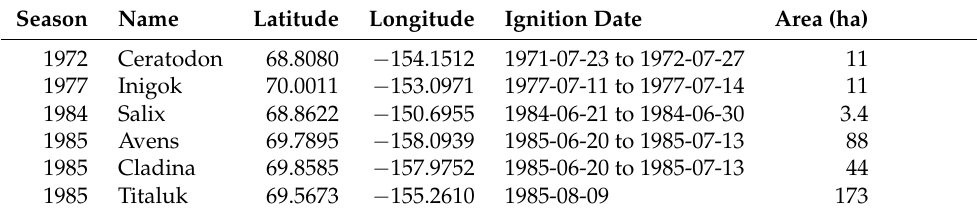
Table A1. Attributes of record-worthy burns (continues in Table